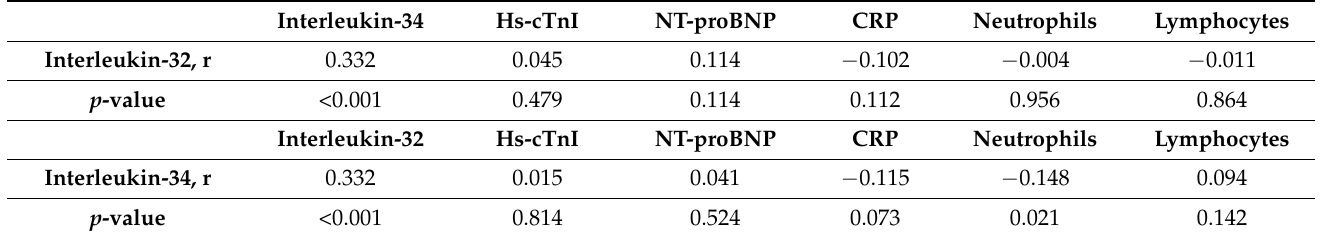
Table 3. Correlation of IL-32 and IL-34 with CV and inflammatory biomarkers.